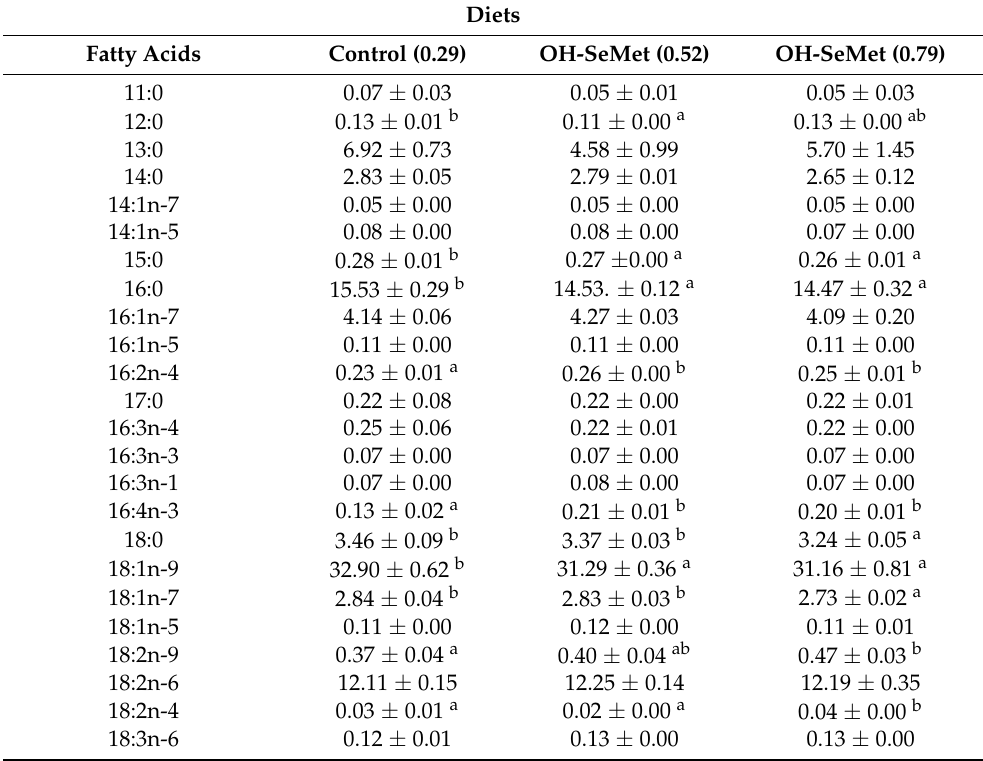
Table 7. Fatty acids composition of total lipids from whole body of gilthead seabream fed diets with different supplementation of OH-SeMet (% total identified fatty